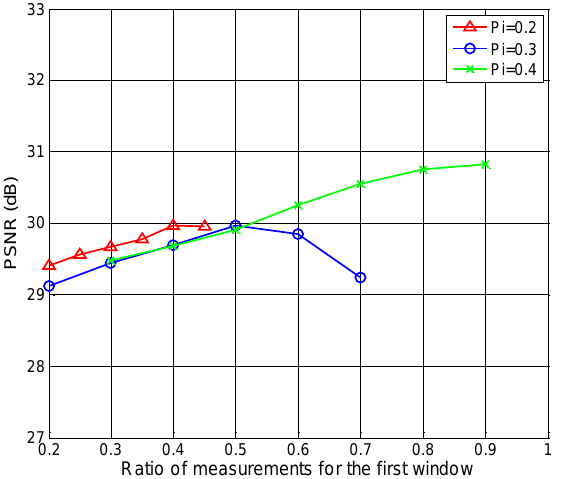
Figure 11. The PSNR performance with different number of measurements for the first